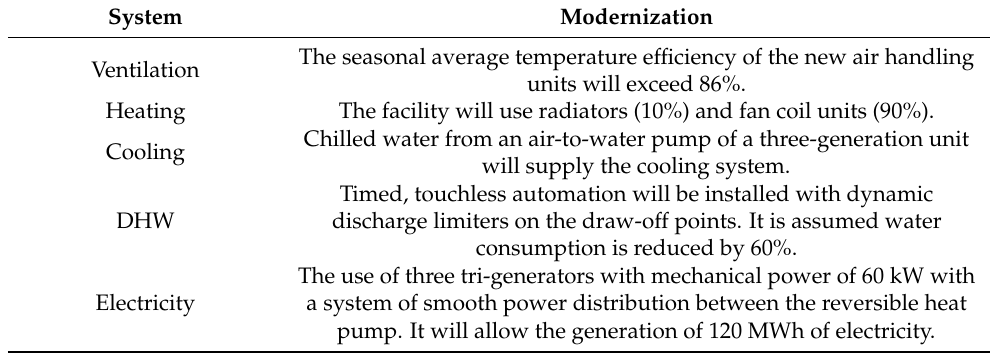
Table 10. Scope of modernization